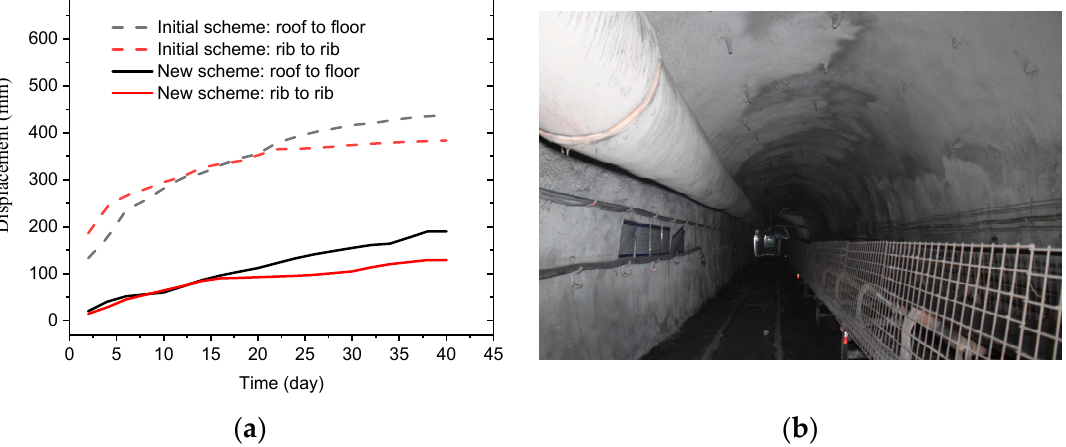
Figure 16. Deformation characteristics on the roadway surface. ( a ) Amount of the surface deformation; ( b ) image of the surface deformation.